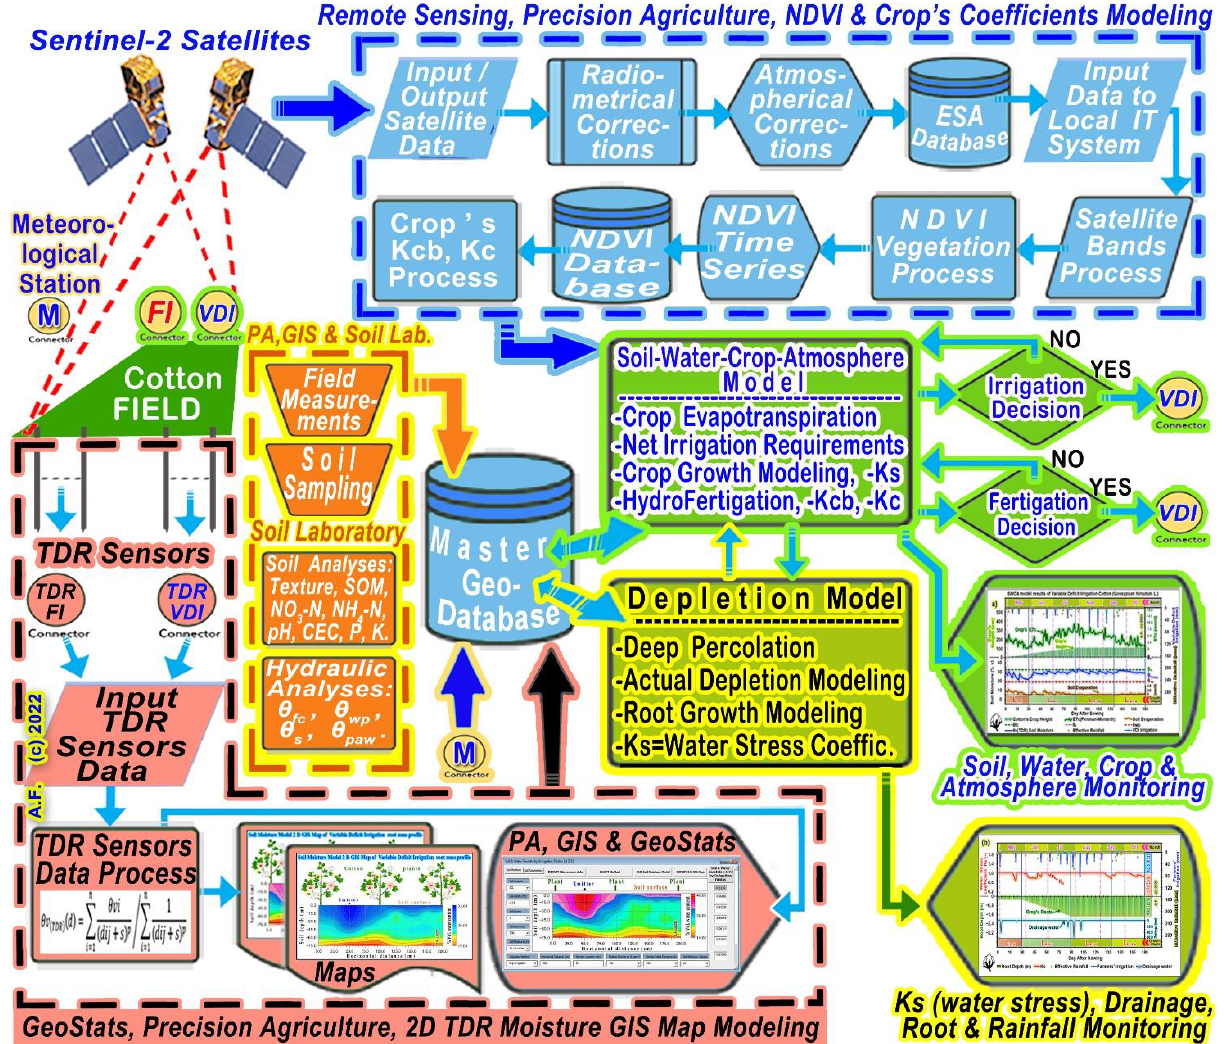
Figure 1. The flow chart of the conceptual design of the soil and hydraulic analyses; field measure- ments; TDR sensor monitoring; satellite monitoring; 2D TDR soil moisture GIS map modeling; and SWCA, depletion, and NDVI models developed in the present study.